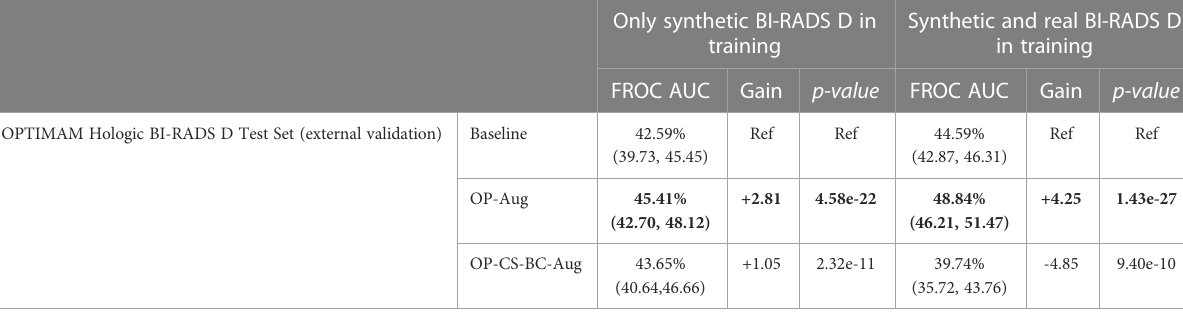
The columns on the left correspond to the models trained without real BI-RADS D mammograms. The baseline models were trained without synthetic images. The 95% Con fi dence Intervals of the FROC AUC are in parenthesis. The p-value was computed using the DeLong's method with a maximum of 10 FPPI. Bold values correspond to the best performing strategy. Ref corresponds to the reference